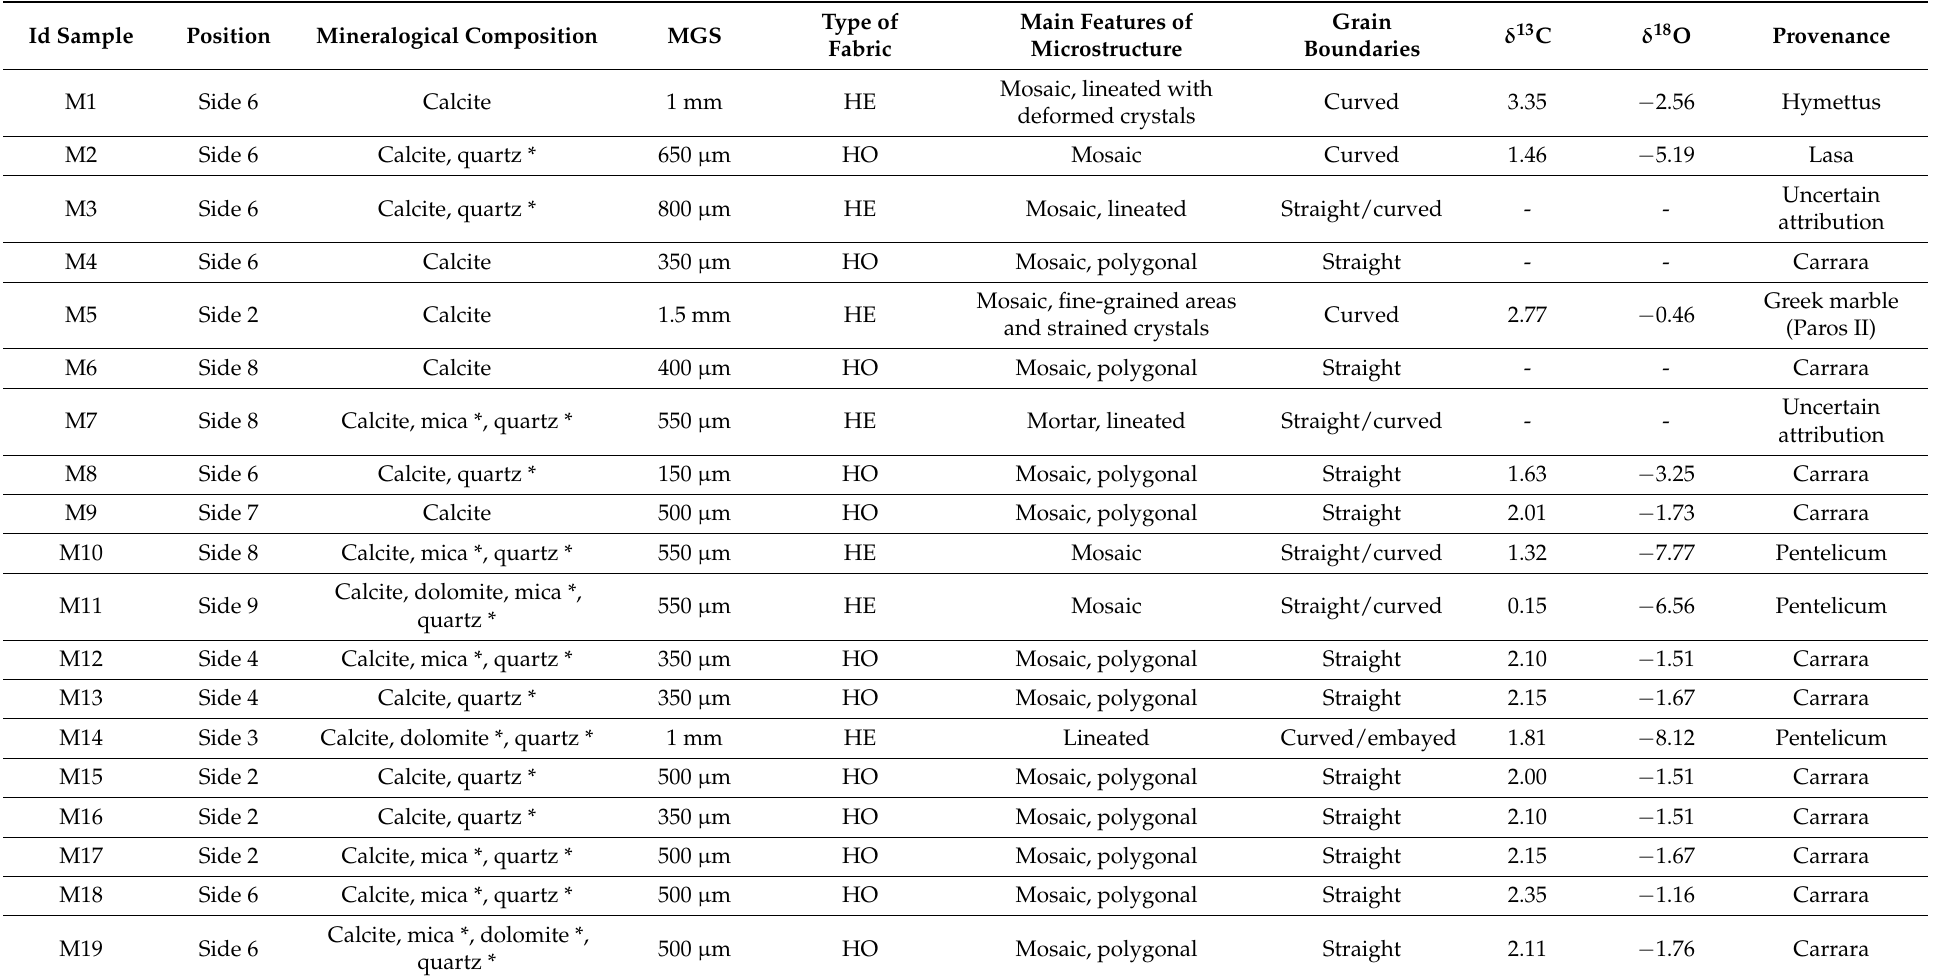
Table 2. Summary of the main minero-petrographic and isotopic features of analyzed marble